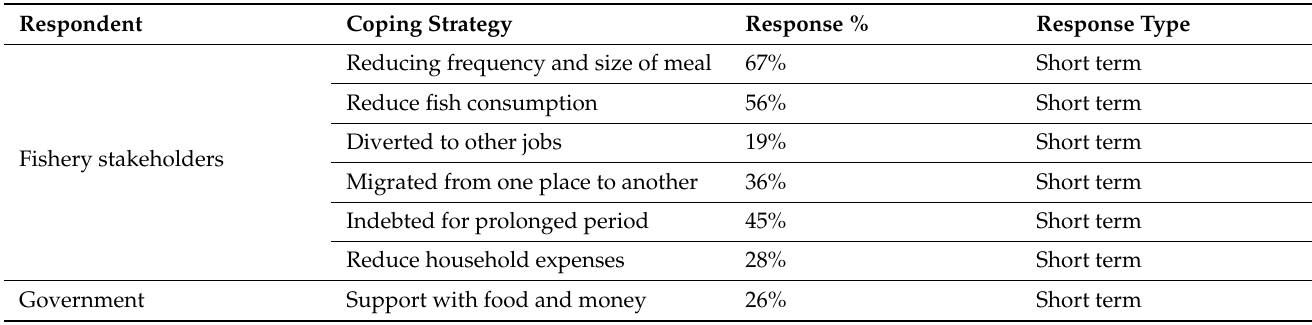
Table 3. Responses of fish farmers and traders as a result of the effects of COVID-19 pandemic.